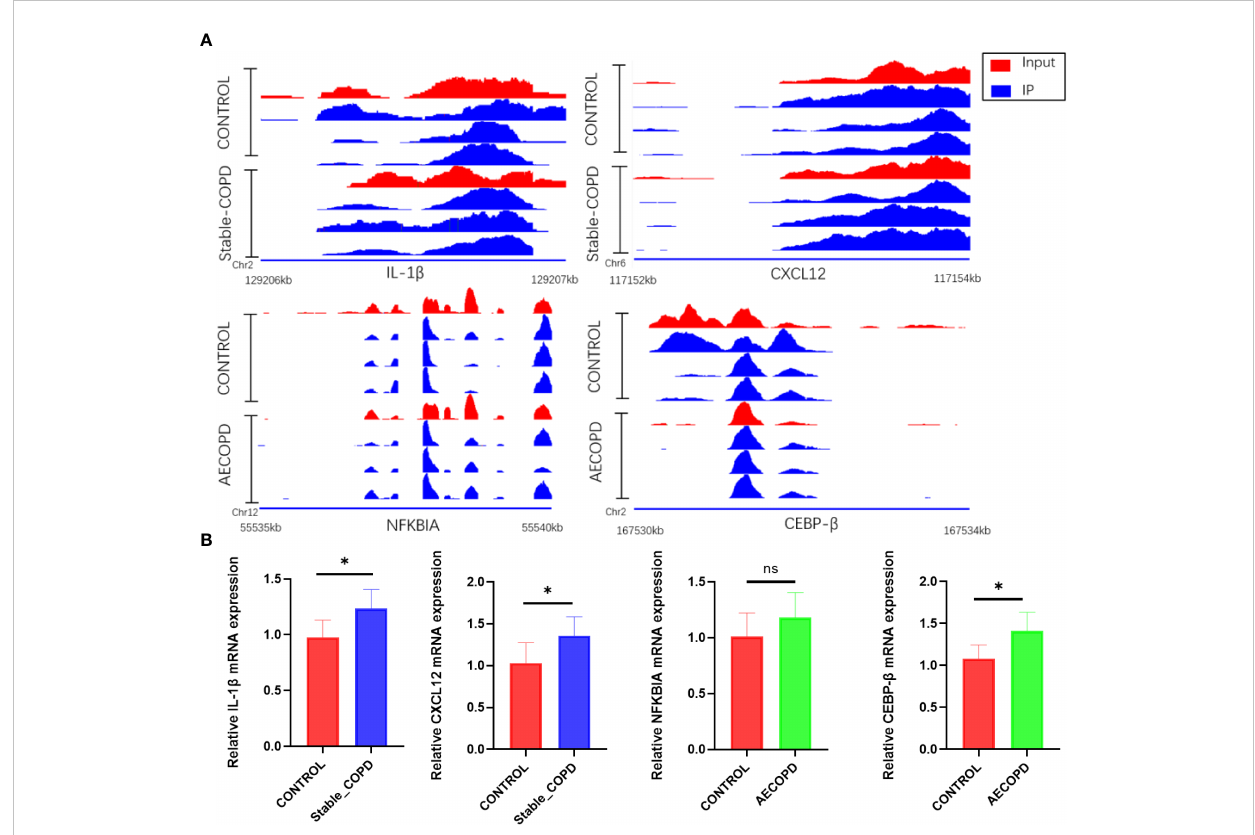
FIGURE 9 Changes in IL-1 b , CXCL12, NFKBIA, and CEBP- b m6a modi fi cations and mRNA expression levels during the development of COPD: (A) IGV tracks display the regional distribution of peaks in IL-1 b , CXCL12, NFKBIA, and CEBP- b genes. (B) Detection of IL-1 b , CXCL12, NFKBIA and CEBP- b mRNA expression levels by RT-qPCR (* P < 0.05). ns,